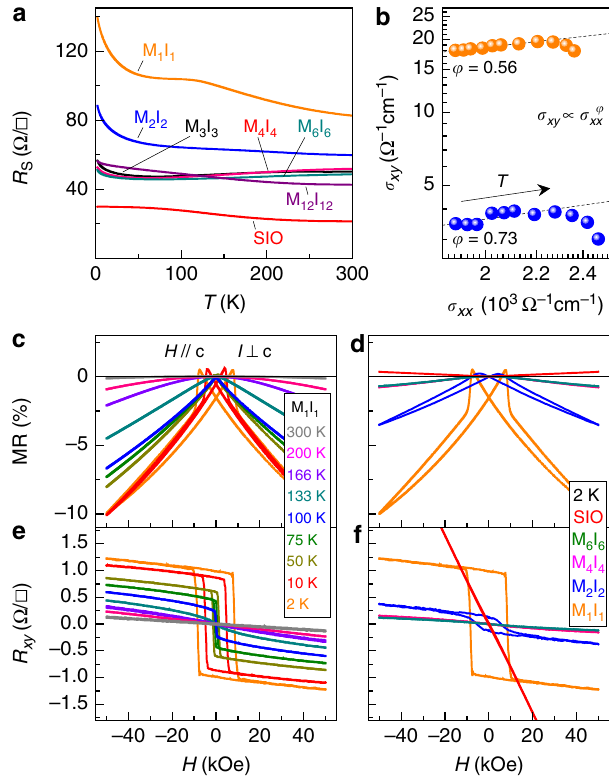
Figure 4 | DC transport and anomalous Hall effect. ( a ) R S ( T ) for SMO–SIO superlattices with all samples displaying semimetallic and metallic behaviours. MR( H ) ¼ [ R S ( H )– R S (0)]/ R S (0) (cid:3) 100% with H // c for ( c ) M 1 I 1 at various temperatures and ( d ) short-period samples ( n r 6) at 2K, where the colour scheme is identical to ( a ). R xy ( H ) with H // c for ( e ) M 1 I 1 at various temperatures and ( f ) short-period samples at 2K that clearly display a nonlinear behaviour attributed to a magnetism induced anomalous Hall effect. ( b ) Scaling plot of s xy and s xx where they are determined using the total superlattice thickness.